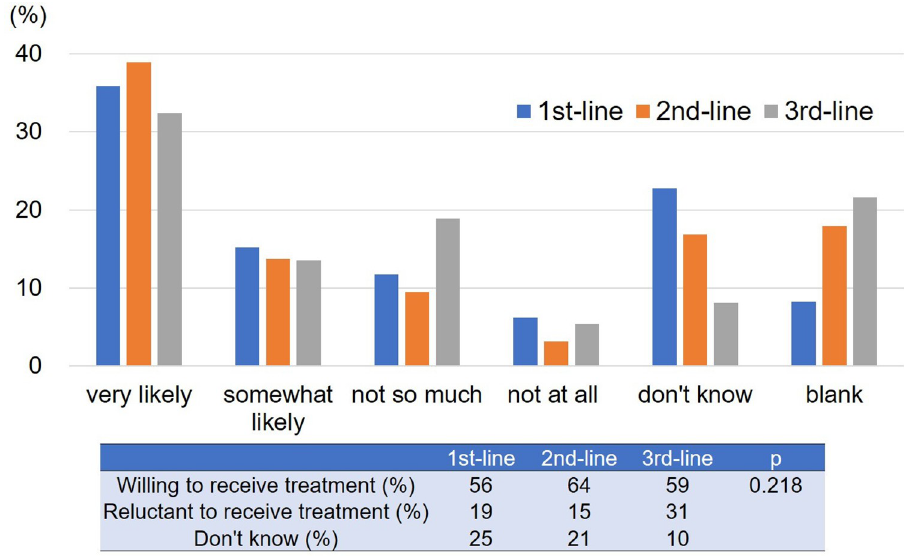
Fig 3. The response and the change in the response rate to Question 3. Approximately 60% of patients responded positively in 1 st to 3 rd treatment line.